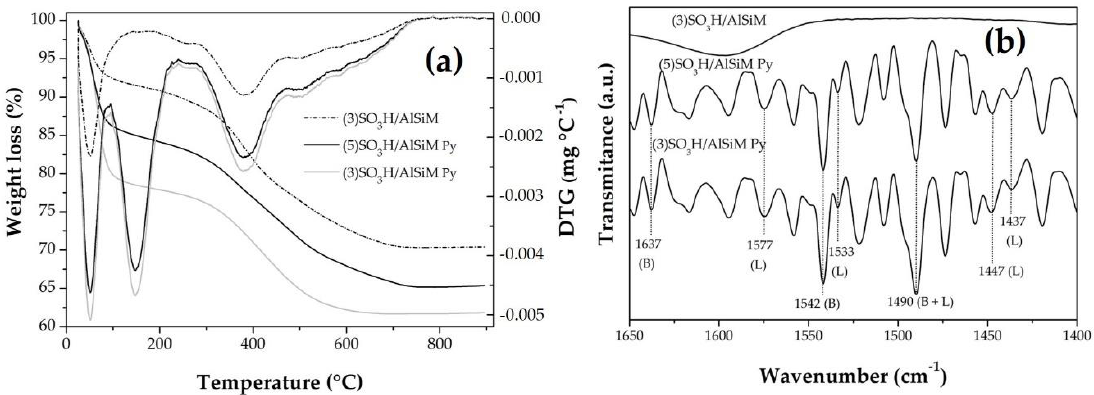
Figure 5. TGA / DTG curves ( a ) and FTIR spectra ( b ) of catalysts without / with adsorbed pyridine: (3) Figure 5. TGA/DTG curves ( a ) and FTIR spectra ( b ) of catalysts without/with adsorbed pyridine: (3) SO 3 H / AlSiM and (3 or 5)SO 3 H / AlSiM SO 3 H/AlSiM and (3 or 5)SO 3 H/AlSiM Py.